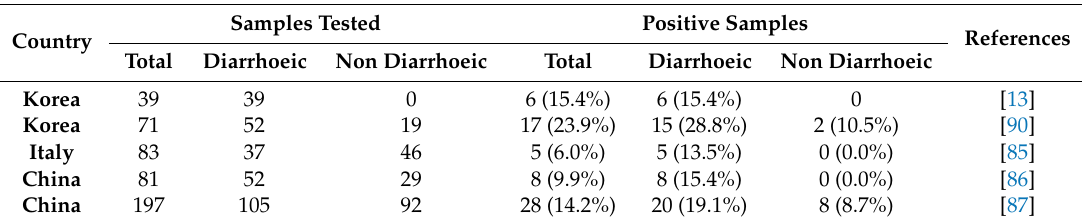
Table 3. Molecular studies detecting FeKoV in cats. Prevalence in diarrheic and non-diarrheic samples are